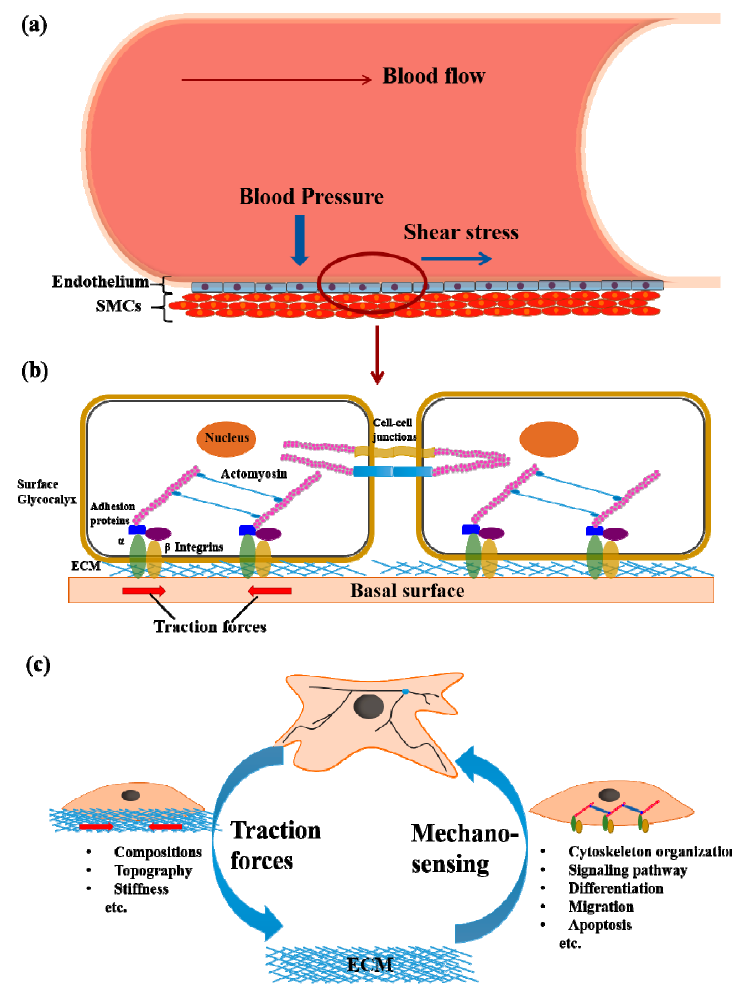
Figure 1. Schematic illustrations of ( a ) endothelial cells that form the interior surface of blood vessels subjected to stresses from the flowing blood; ( b ) The cell–cell junctions and cell–substrate tractions exerted by endothelial cells; ( c ) Positive feedback in cell–extracellular matrix (ECM) mechanotransduction. SMCs: smooth muscle cells.